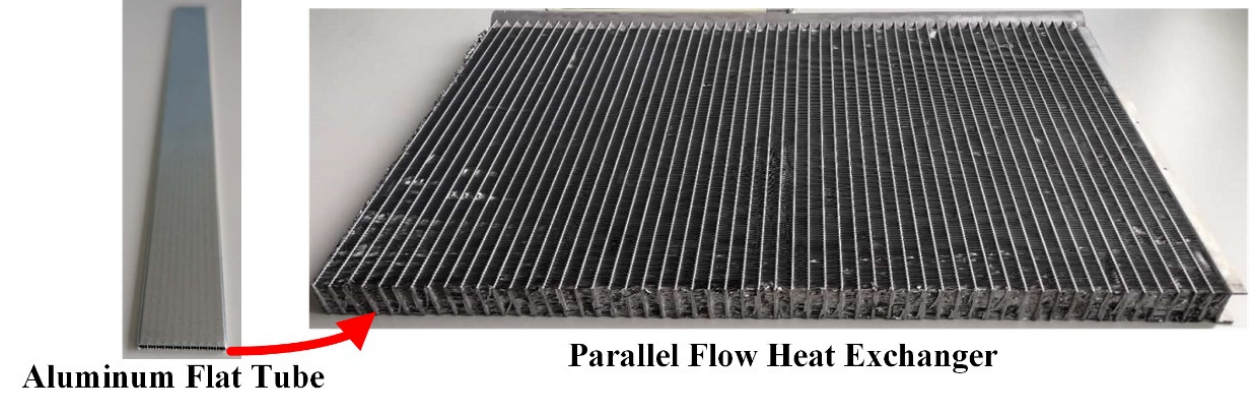
Figure 1. Microchannel Aluminum Flat Tube and Parallel Flow Heat Exchanger.